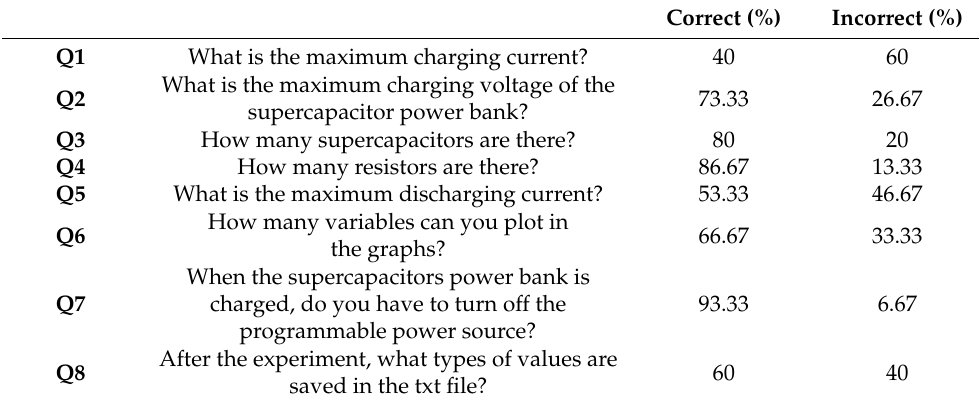
Table 6. Responses from students to self-assessment